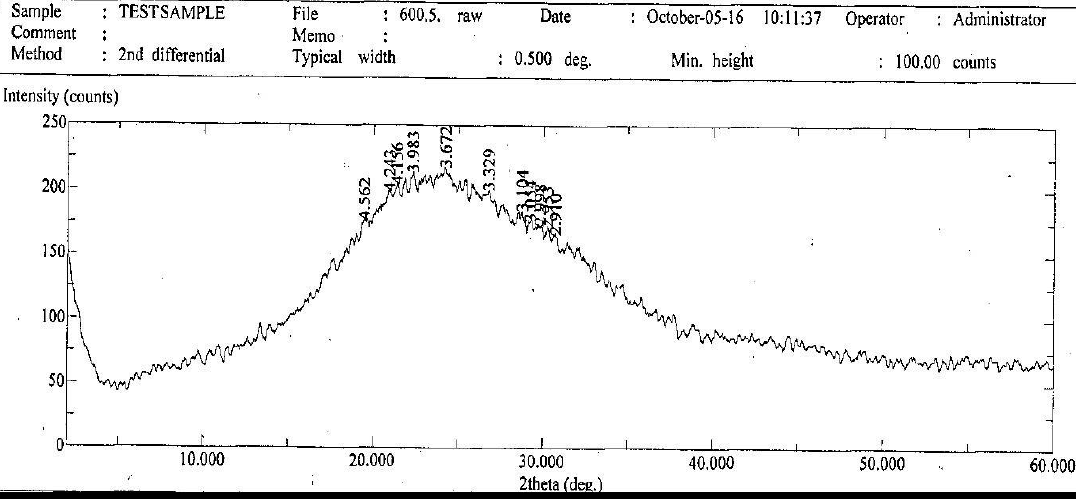
Fig. 7a: XRD for pure polyaniline thin films.